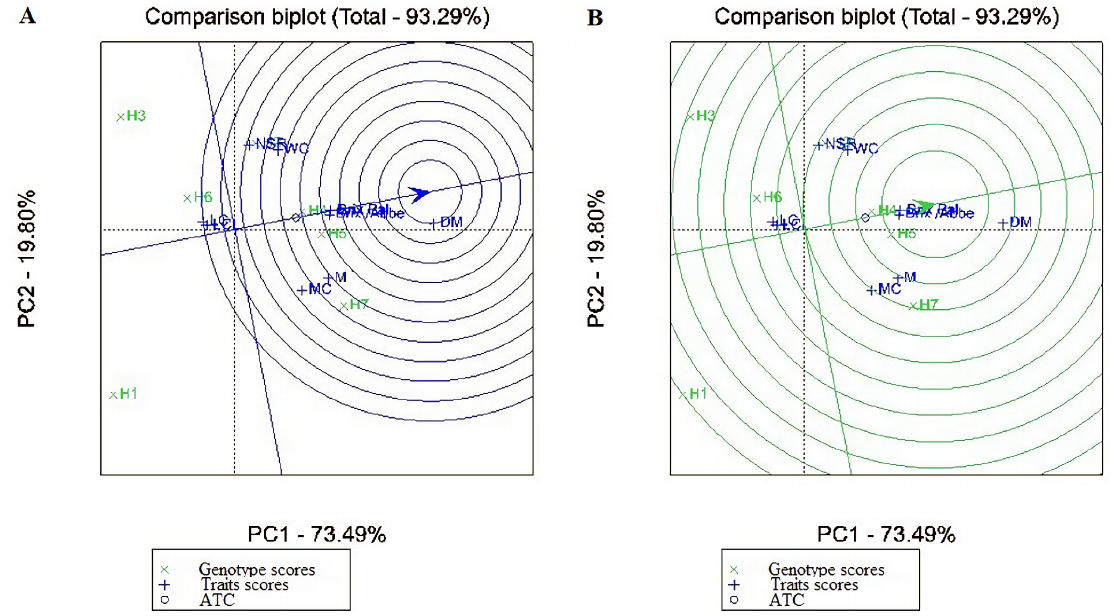
Figure 4. Biplot on different maize hybrids in irrigation treatment. ( A ) comparison based on the traits, ( B ) comparison based on the genotype. Ear length (LC), net ear length (LCL), ear weight (WC), number of kernel rows (NSR), Brix/Atago Pal-1, Brix/Abbe, soil moisture content (M), dry matter content of cob (DM), moisture content of cob (MC). (H1: Noa, H2: Dessert R78, H3: Dessert R72, H4: Messenger, H5: SF1379, H6: Honey, H7: GSS5649).